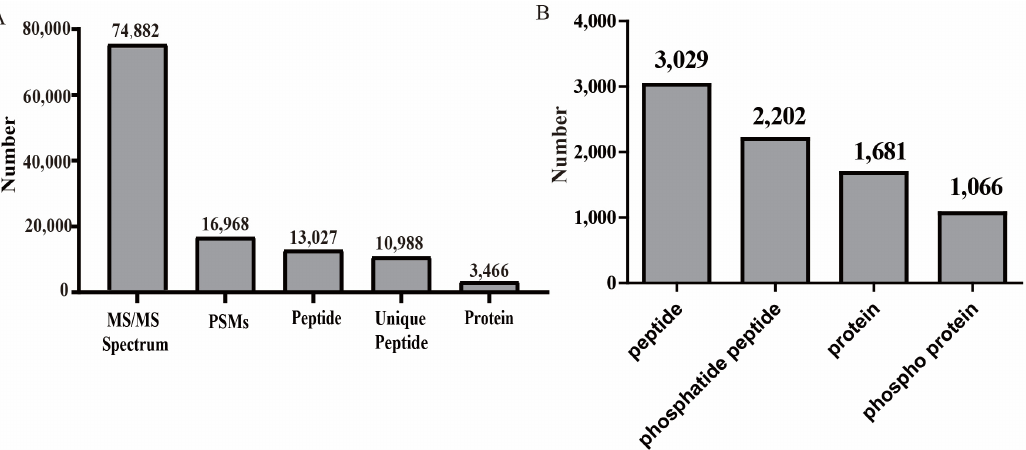
Figure 1. The numbers of identified peptides were statistically analyzed. ( A ) Number of the different peptides identified in the proteome data. ( B ) Number of the different peptides identified in the phosphoproteomic data.